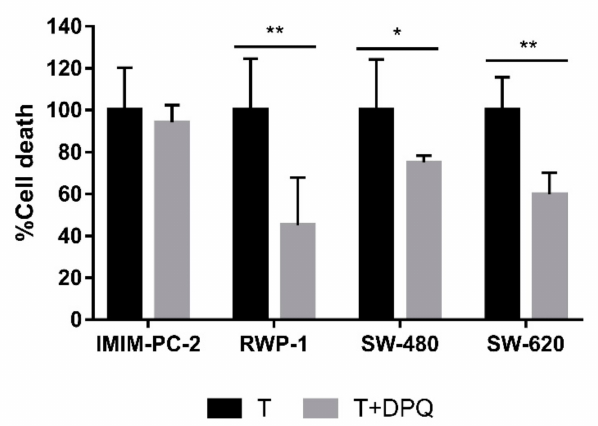
Figure 2. E ff ect of PARP-1 inhibition in CLytA-DAAO-induced cell death. IMIM-PC-2, RWP-1, SW-480 and SW-620 cell lines were treated with CLytA-DAAO and D-Ala (T), in the presence or absence of 3,4-Dihydro-5(4-(1-piperindinyl)butoxy)-1(2H)-isoquinoline (DPQ) for 24 h and cell viability was determined by flow cytometry. Data represent the percentage of cell death, normalizing the treatment with CLytA-DAAO as 100% ± SD with n ≥ 3. * indicates a p -value < 0.05 and ** p -value < 0.01.